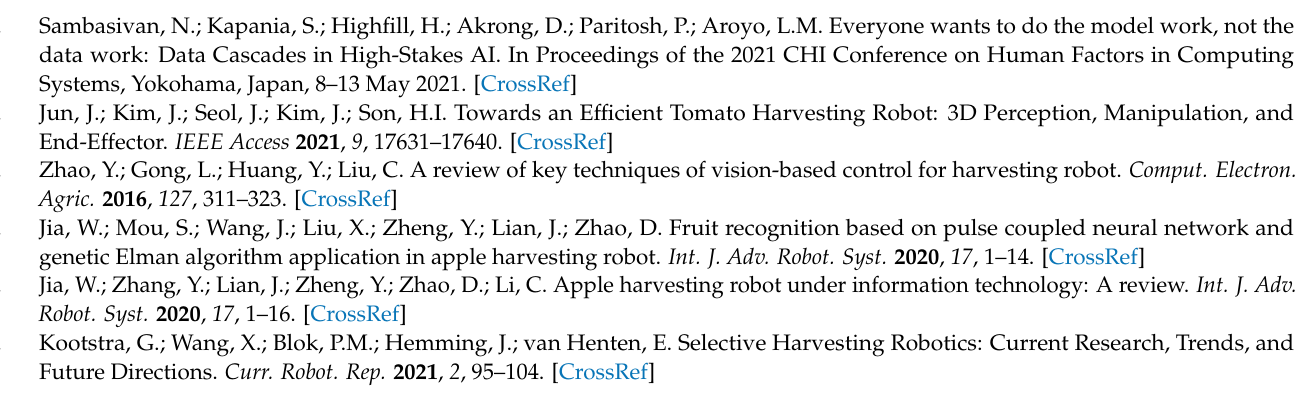
illumination; Figure S2. Visualization test results of yolov5-s-basic and yolov5-s-bal; Figure S3. Visualization test results of yolov4-s-basic and